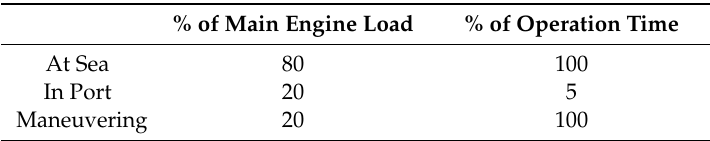
Table 1. Engine Load